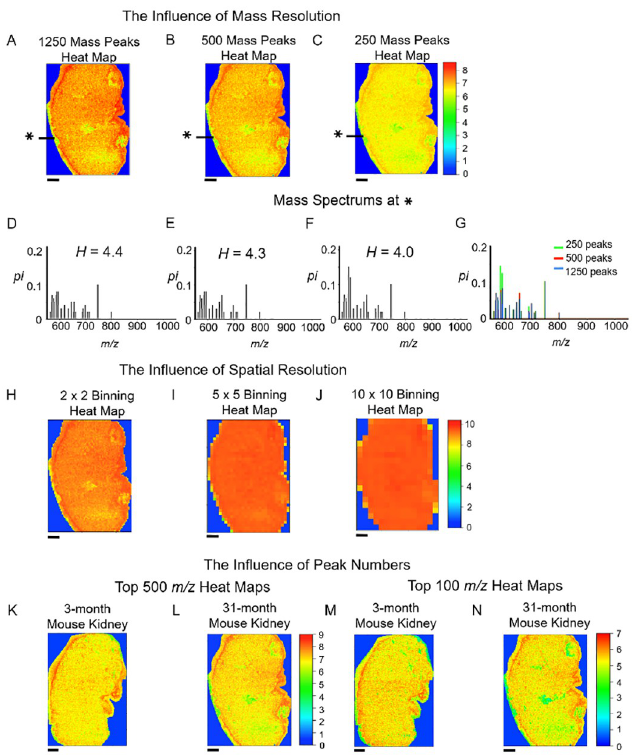
Fig 5. Effects of mass and spatial resolutions on entropy heat maps. ( A-C ) Entropy heat maps with low m/z resolutions created by the reduction of the number of intensities to ( A ) 1250, ( B ) 500, and ( C ) 250. ( D-F ) Mass spectra for three mass resolutions at the identical position (indicated * in ( A-C )). ( G ) Three spectra together with the original spectrum with 2500 intensities. ( H-J ) Reduced spatial resolutions, by the binning of pixels by the factor ( H ) 2, ( I ) 5, and ( J ) 10. ( K-L ) Entropy heat maps with top 500 m/z peaks. ( M-N ) Entropy heat maps with top 100 m/z peaks. Scale bars indicate 1